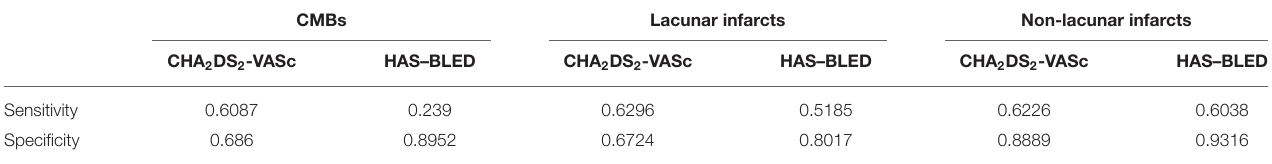
TABLE 4 | Sensitivity and specificity of re-weighted CHA 2 DS 2 -VASc and HAS–BLED scales in relation to the three neuroimaging outcomes.